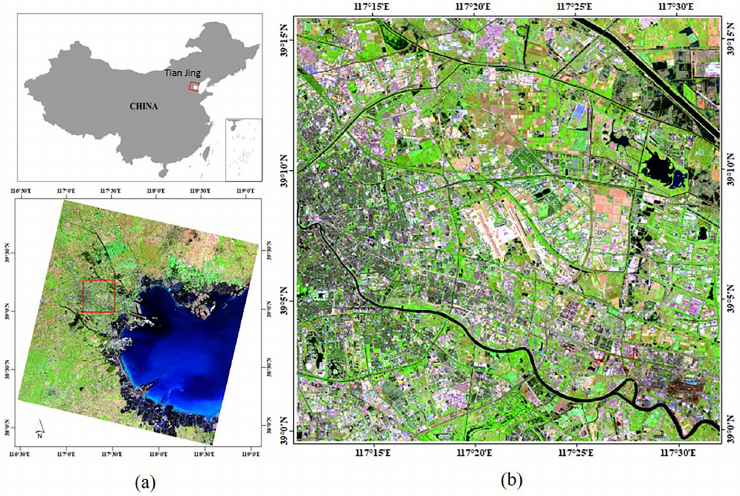
Figure 3. Overview of the study area: ( a ) the Landsat-8 image with Path=122 and Row=38 in the Worldwide Reference System (WRS); ( b ) The false color composite image in the study area (R: B7, G: B5, B: